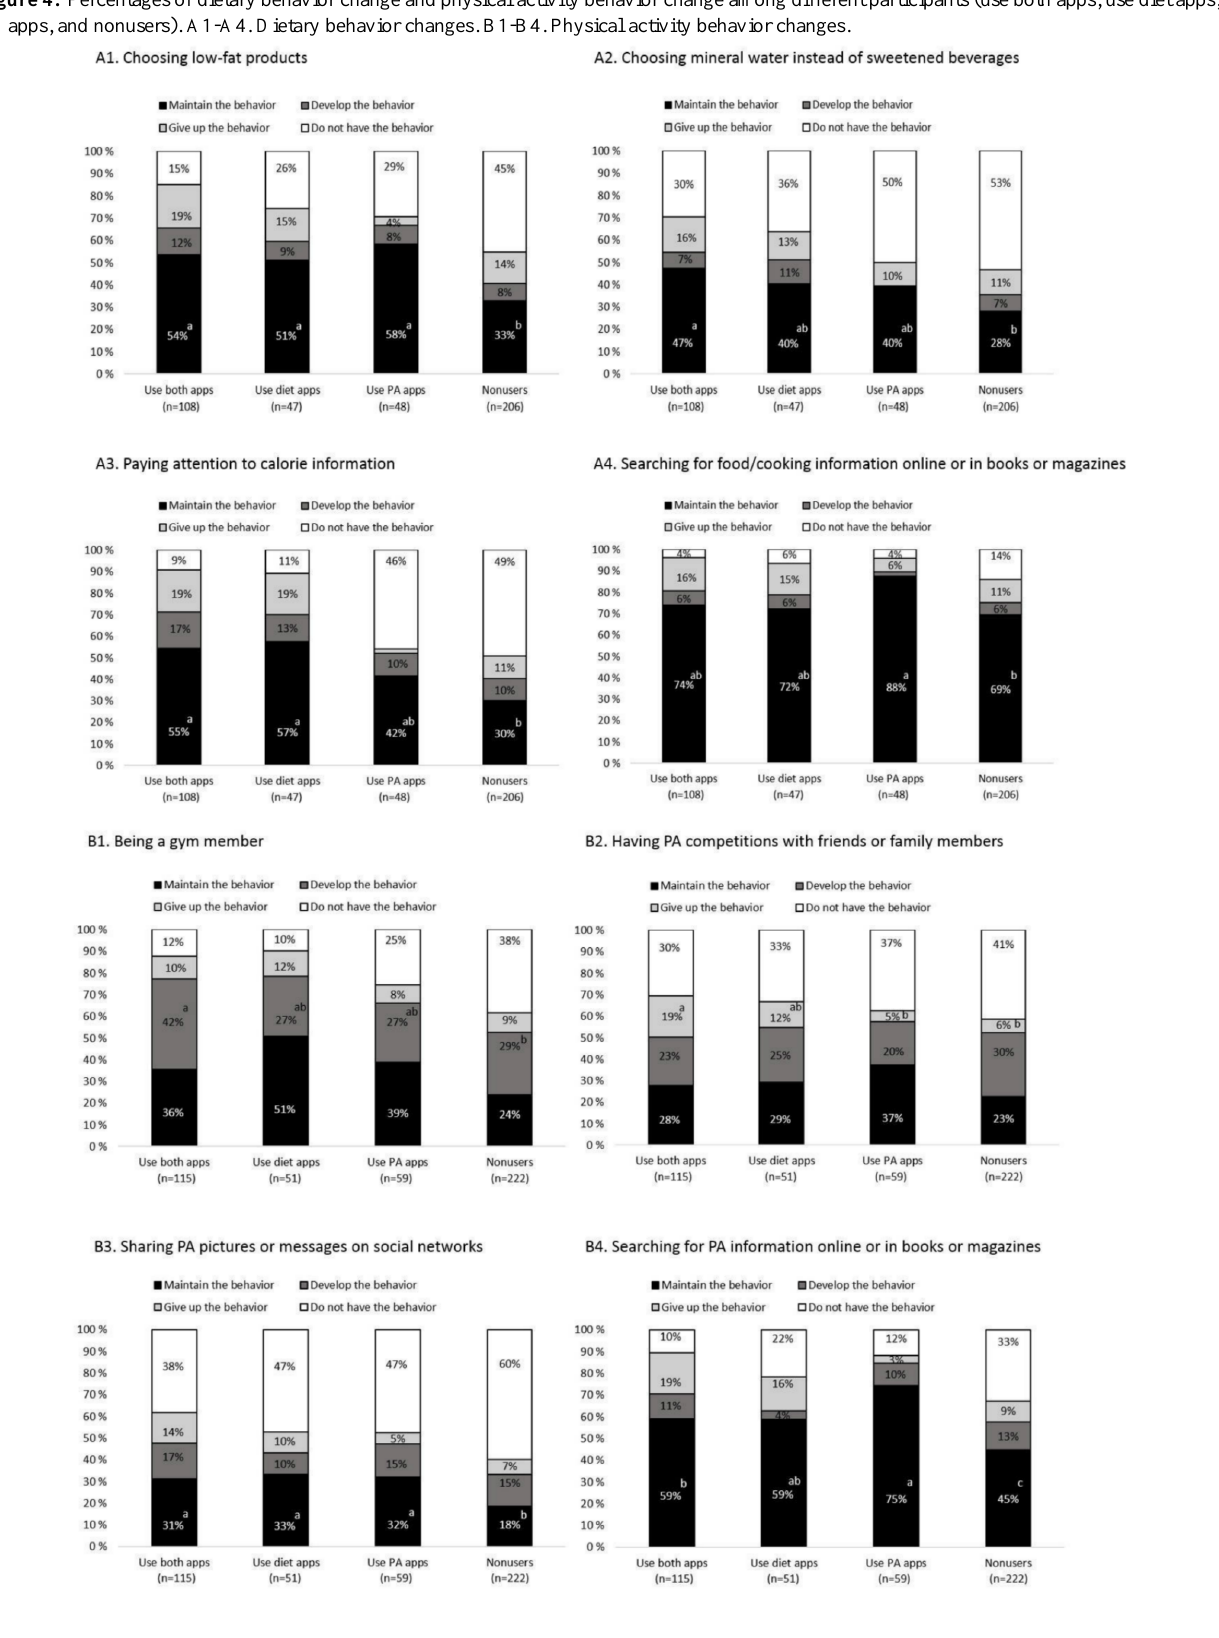
Figure 4. Percentages of dietary behavior change and physical activity behavior change among different participants (use both apps, use diet apps, use PA apps, and nonusers). A1-A4. Dietary behavior changes. B1-B4. Physical activity behavior